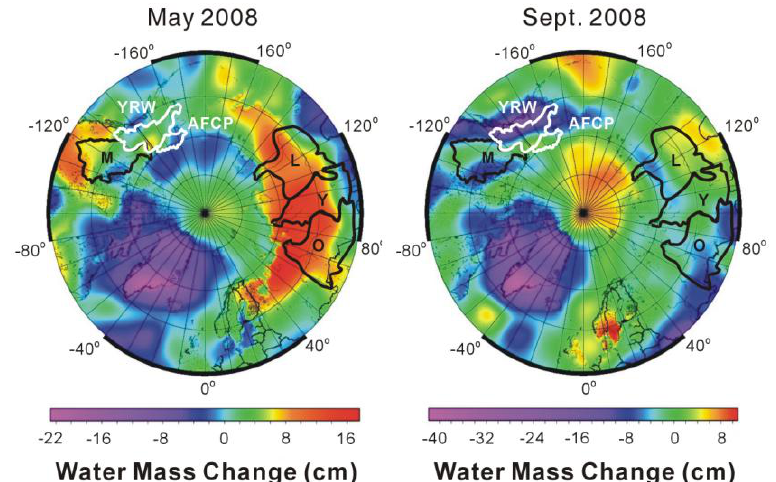
Figure 2. GRACE water equivalent mass changes on the northern hemisphere (top) and Alaska-western Canada (bottom) during May 2008 (left) and September 2008 (right) are shown. The Yukon River watershed and the Arctic foothills-coastal plain are delineated. Other important permafrost watersheds in Eurasia (Lena, Yenisei and Ob’) and North America (Mackenzie) are shown [18]. The seasonal maximum and seasonal minimum water equivalent mass change occur in May and September,